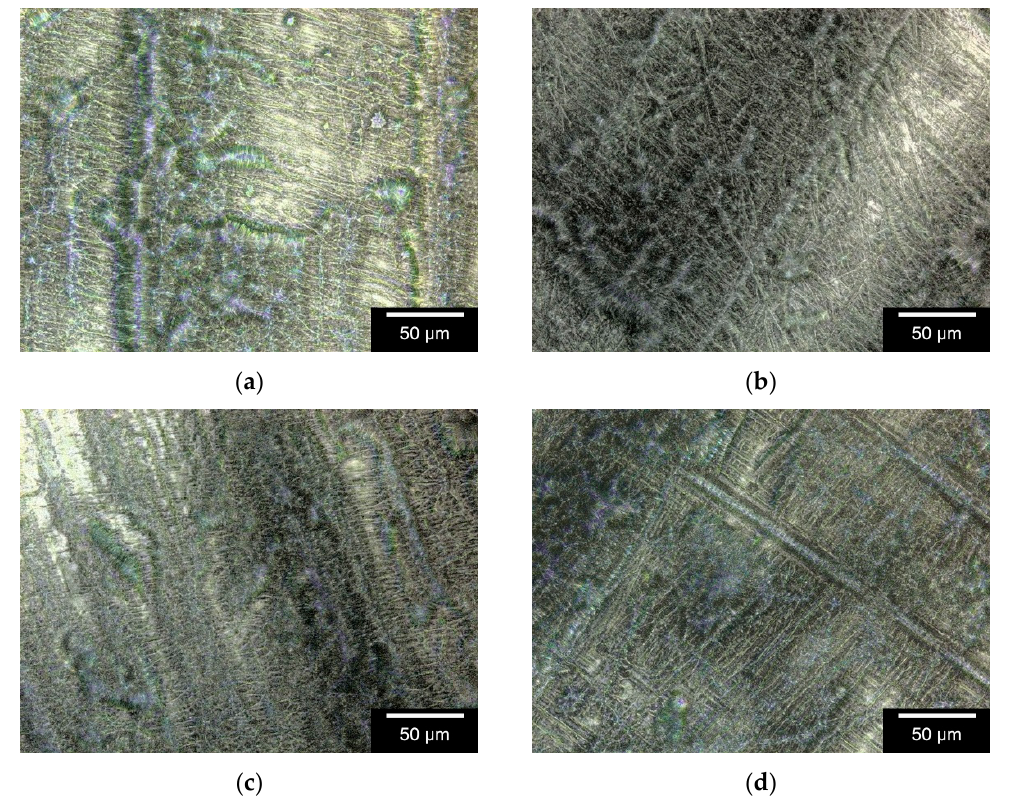
Figure 3. Surface roughness of specimens photographed with a Keyence 3DLSM VK-X210; 1000x